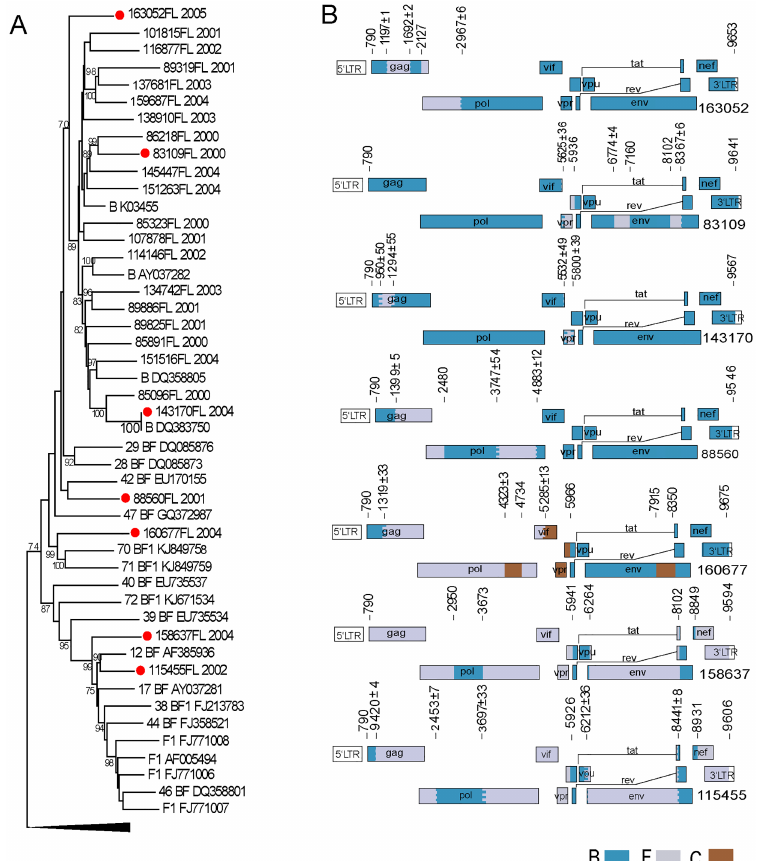
Fig 3. Phylogenetic tree of near full length sequences and recombination patterns corresponding to BF recombinant sequences. (A) Maximum likelihood phylogenetictree of 25 HIV-1 NFL sequences obtained from Argentinean MSM. Those sequencescharacterized as BF recombinants once genetic mosaic was defined,are indicatedwith a red dot in the terminal node. Bootstrap values (cid:21) 70 are indicatedin the nodes. (B) Maps of the genetic mosaic patterns includingbreakpoint locationsof the 7 BF recombinant NFL sequences.